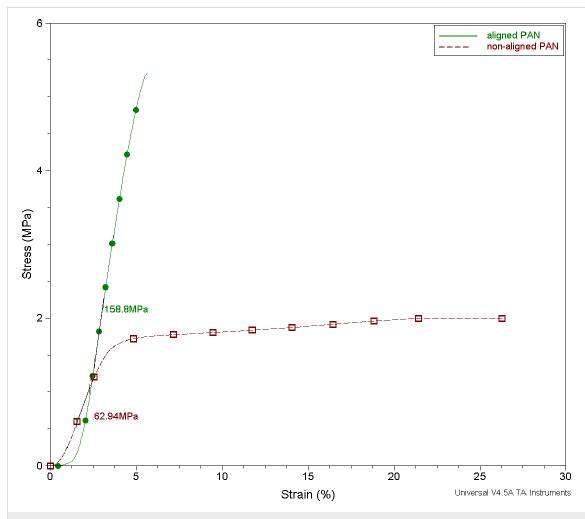
Figure 2: Stress–strain plots of webs of aligned and non-aligned PAN